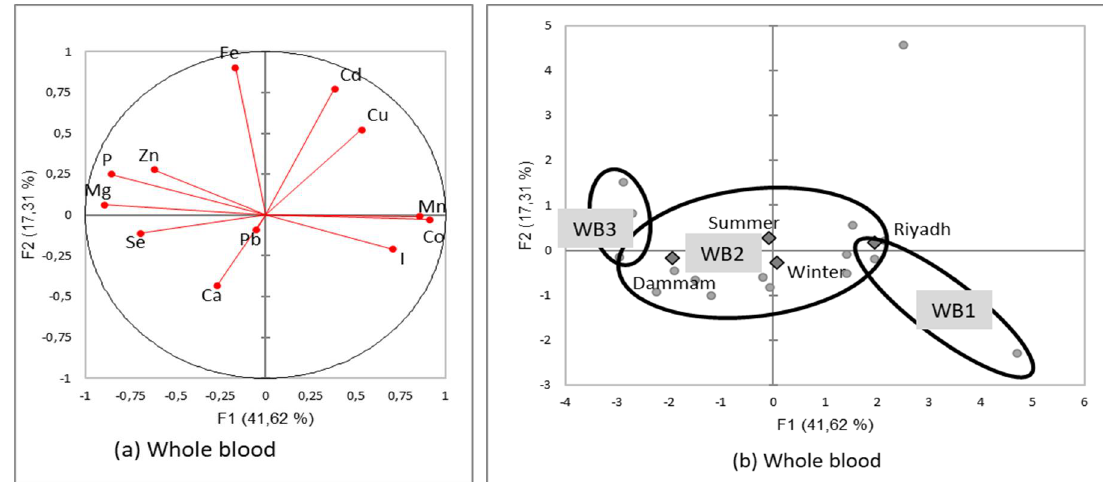
Figure 8. Correlation circles ( a ) for the two first factors of the Principal Components Analysis demonstrating the relationships between minerals in camel whole blood and the main factorial plan ( b ) with representation of the two mineral patterns of the whole blood sampled in two regions of Saudi slaughterhouses at two seasons (squares represents the mean value for each region and season and dots the different whole blood sample values). Table 14. Mean values of minerals in camel whole blood based on Ascending Hierarchical Classifi- cation patterns [µg/L].